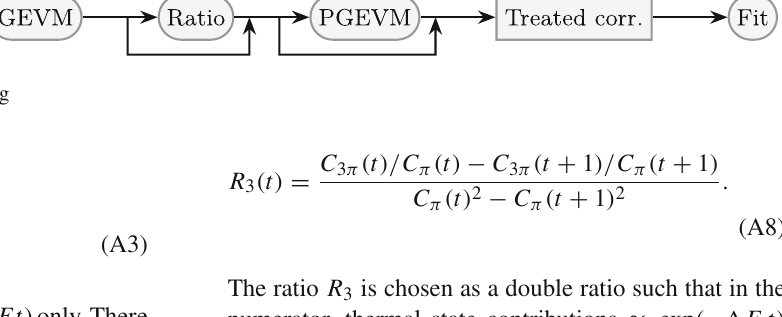
is the “log effective